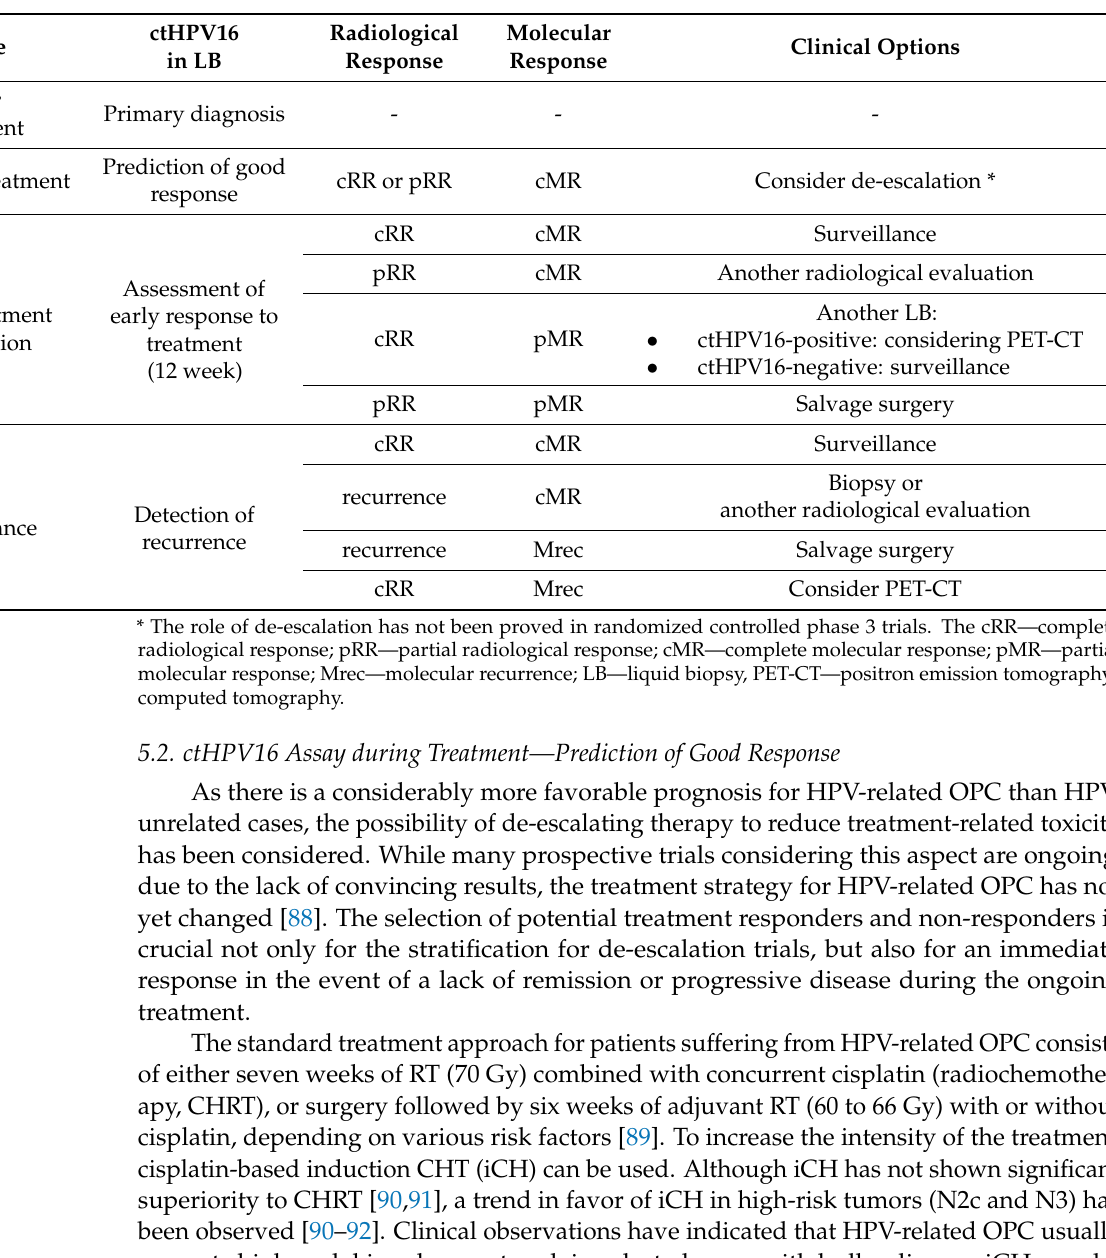
Table 2. The potential role of ctHPV16-based molecular response (MR) at subsequent stages of the management of patients with HPV-related